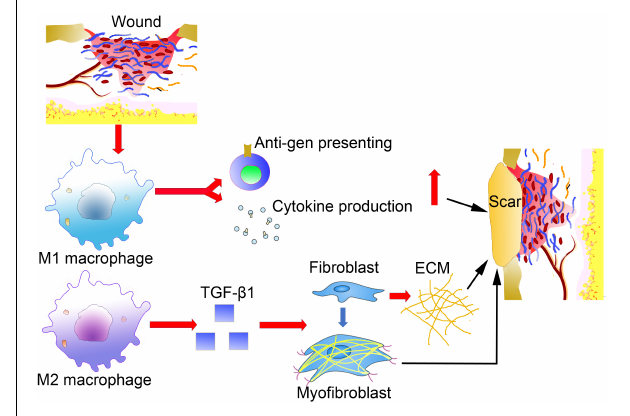
FIGURE 2 | The indirect effects of macrophages in abnormal scar